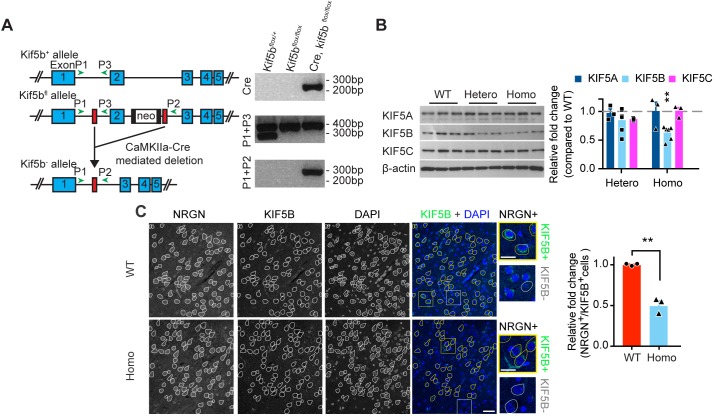
Targeting of Kif5b gene in CaMKII-Cre/Kif5bfl/fl mice and validation of the conditional knockout mice.(A) Scheme of KIF5B knockout strategy (left panel). The blue rectangles (E1, E2, E3, E4, and E5) annotated exon 1, exon 2, exon 3, exon 4, and exon 5 of the Kif5b gene, respectively. The white rectangle with black bars on each side (each bar representing a flippase recognition target site) represented the 1.7 kb frt-NeoR-frt cassette. The red rectangles represent the LoxP sites (drawing not to scale). The green arrowheads indicated the designated annealing positions of genotyping PCR primers. Genotyping analysis of PCR product from mice DNA with different genotypes of the Kif5b gene (right panel). Cre primers were used to detect Cre recombinase gene. Primers P1 and P3 were used to identify Kif5bfl/+ and Kif5bfl/fl genotypes. Primers P1 and P2 were used to identify Kif5b conditional knockout, Kif5b-/- genotype. (B) Western blot analysis probed with anti-KIF5A, anti-KIF5B, anti-KIF5C and anti-β-actin antibodies. Quantification result in the right panel was presented as the relative fold change compared to wild-type (WT). n = 6 for all groups for the analysis of KIF5B. n = 3 for the analysis of other protein targets. Data were presented in mean + SEM. **p<0.01, One-way ANOVA with post hoc Tukey's HSD. (C) Immunohistochemical staining of sagittal brain sections showed a significant reduction of cells that were both positive for KIF5B and Neurogranin (NRGN) in frontal area on postnatal day (P) 42 ± 1. White traces highlighted NRGN-positive cells. Yellow traces indicated cells that were positive for both NRGN and KIF5B. Yellow and white squares indicate the zoom-in areas of NRGN+/KIF5B+ cells and NRGN+/KIF5B- cells, respectively. Scale bar, 50 μm and 25 μm in magnified inserts. Right panel: quantification of KIF5B knockout in immunohistochemical staining of frontal area. n = 3 for WT. n = 3 for Homo. Data were presented in mean + SEM. **p<0.01,Student’s t-test with Welch's correction.
Figure 6—source data 1.Plotted values for Figure 6.